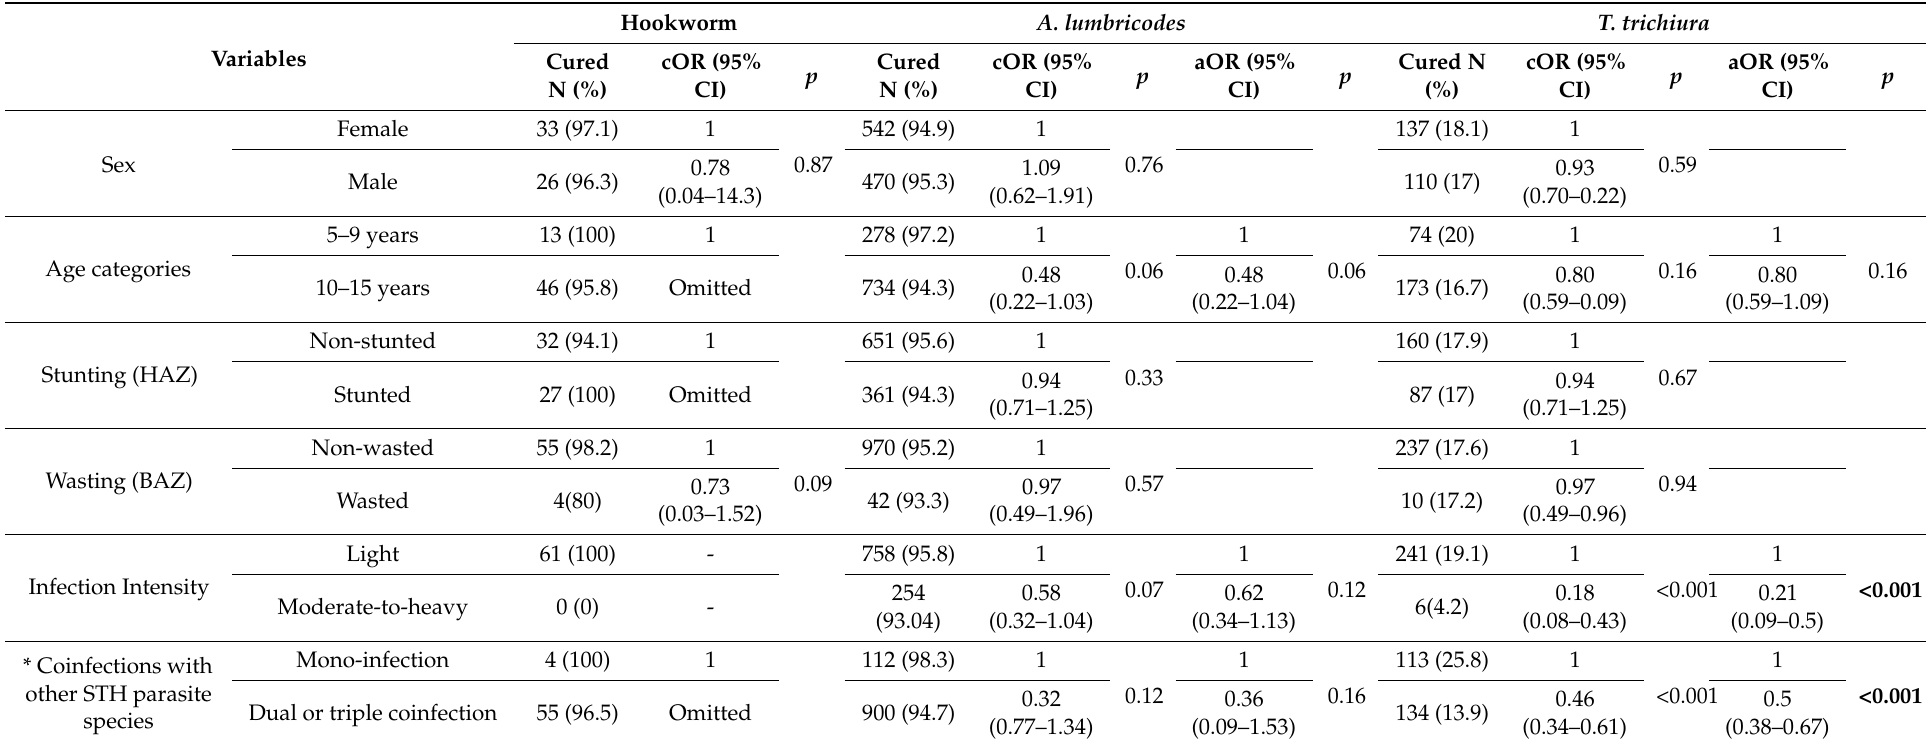
Table 5. Predictors of cure rate at three weeks post-single-dose albendazole mass drug